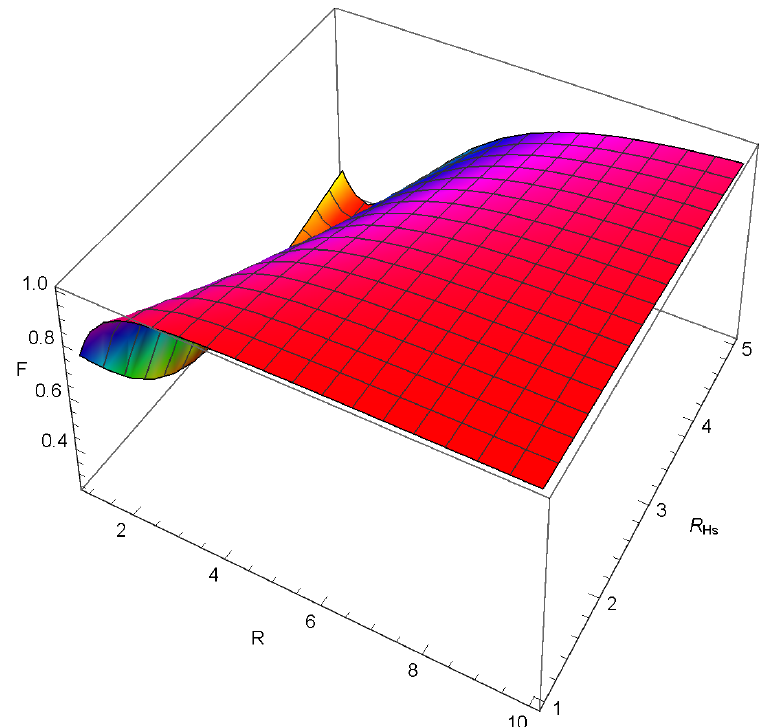
Figure 19. Solution of F ( R ) for p = 2. The evolution of the partial derivative of f ( R ) is obtained using Equations (33) and